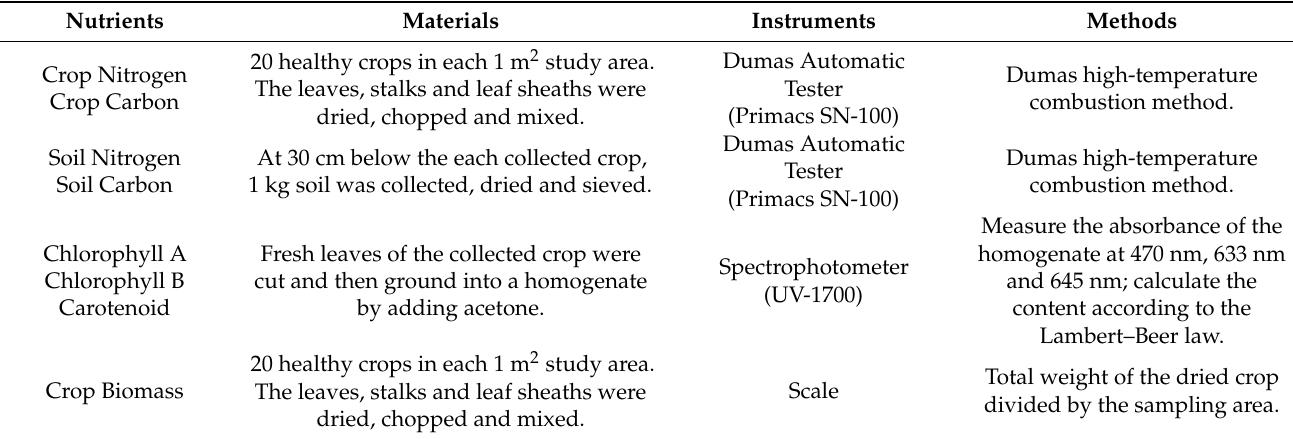
Table 1. The determination method of nutrient